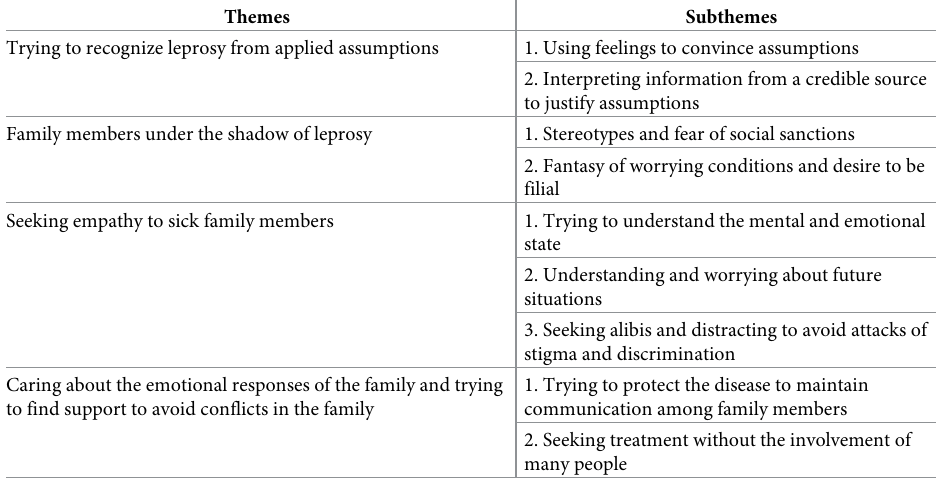
Table 4. Themes, and